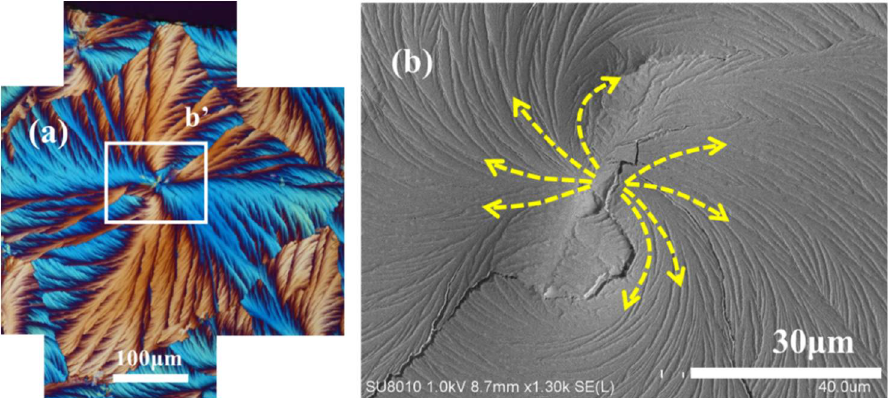
Figure 11. ( a ) POM, b’ indicating the white-squared region to be zoomed-in by SEM and ( b ) SEM micrograph of (S)-MA/PVPh (50/50) blend crystallized at T c = 45 °C.